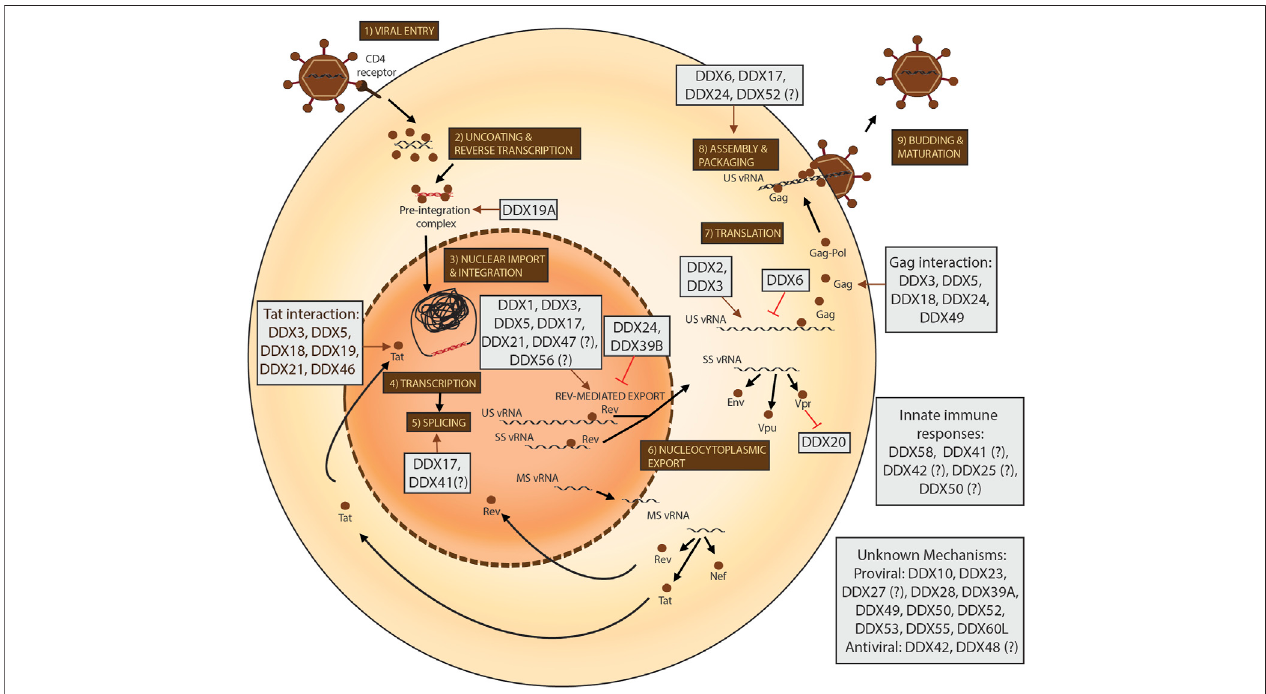
FIGURE 2 | The roles of DEAD-box proteins in the HIV-1 life cycle. The steps of the HIV-1 life cycle are indicated from 1-9. viral RNA is depicted in black and viral DNA in red. Progression of the steps of the life cycle are indicated with black arrows and all viral proteins are depicted as brown circles. The effects of the DEAD-box proteins (in grey boxes) are indicated by either brown arrows for a pro-viral effect and with red lines for an anti-viral effect. DEAD-box proteins with uncharacterised or speculated effects in the life cycle are accompanied by a question mark.